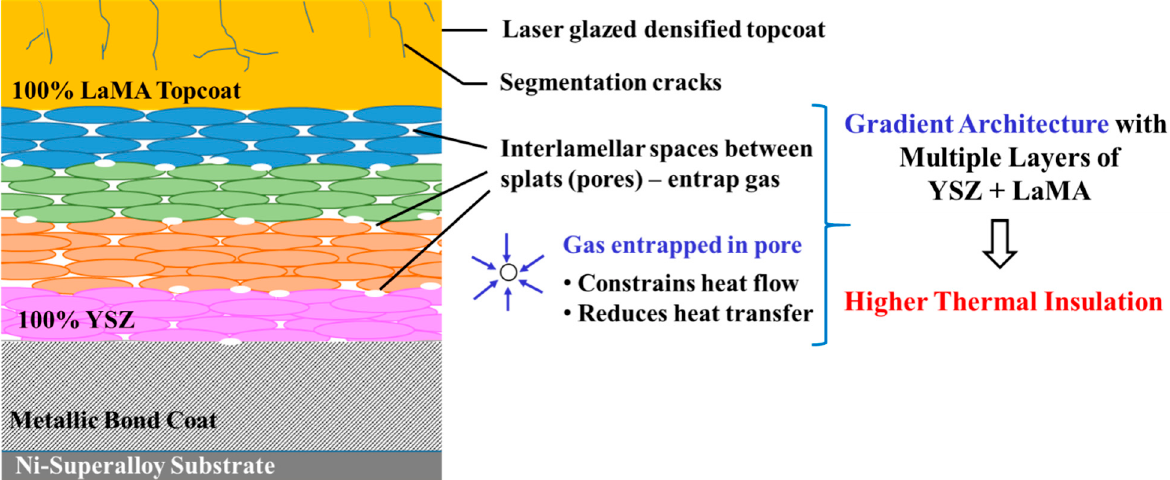
Figure 16. Schematic representation of the heat insulation mechanism in laser-glazed FG-TBC. Laser glazing densifies the top coat. Interlamellar space between splats (pores) entraps gas, constrains heat flow and prevents heat transfer across the coating thickness.